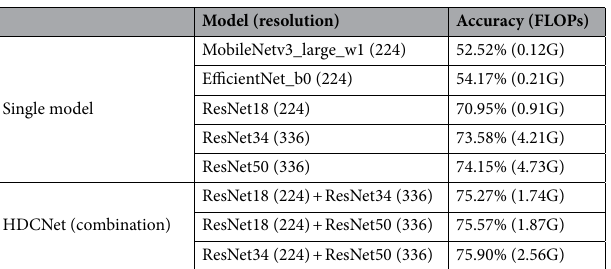
Table 2. Comparison of different methods with the proposed HDCNet according to the Accuracy and